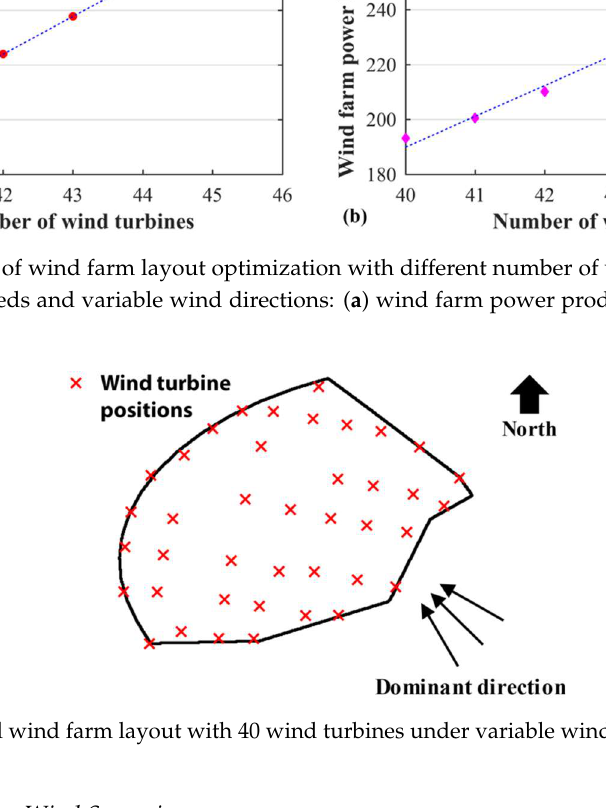
Figure 11. Optimal wind farm layout with 40 wind turbines under variable wind speeds and variable wind directions.